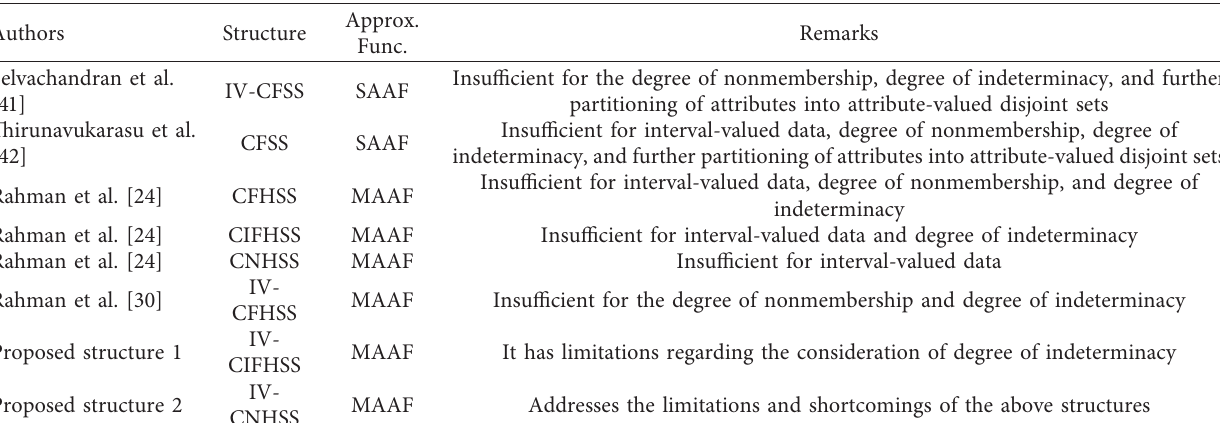
Table 8: Comparison of proposed structures with some existing relevant structures.